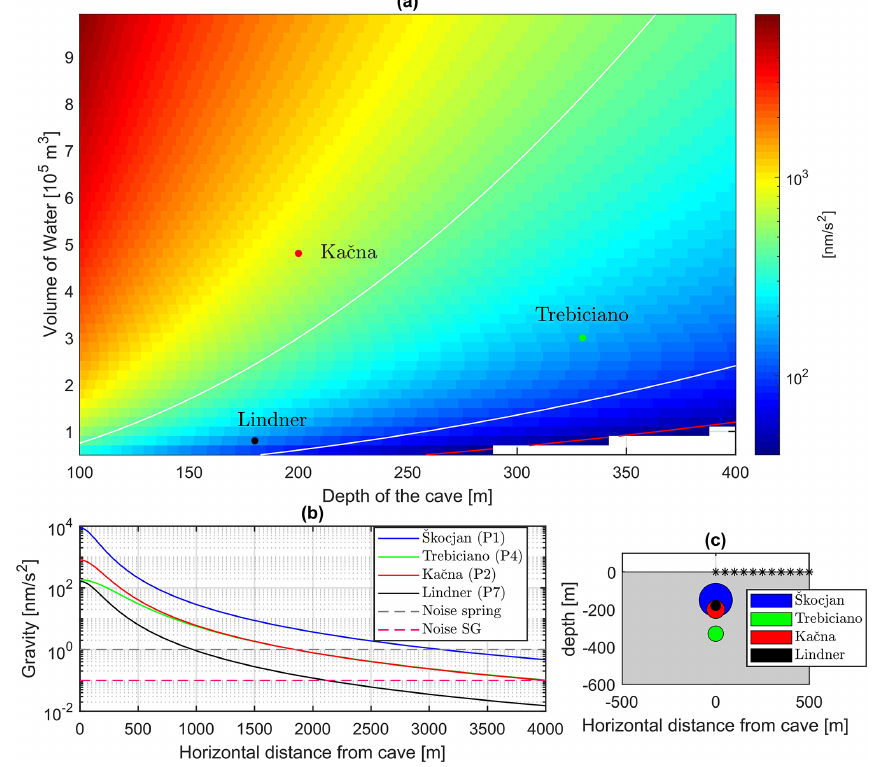
Figure 6. Detectability of gravity signals related to hydrology in karstic areas. (a) Gravity signals simulated for various water volumes stored and depths of the caves. Red line: contour line of 50nms − 2 ; white lines: 100 and 500nms − 2 iso-anomalies. (b) Gravity anomalies for four different cavity volumes filled with water at different depths as a function of the horizontal distance from the cavity centre. Noise levels for a common spring gravimeter and a SG are reported with the dashed lines. (c) Vertical cross-section of the spherical cavities used for approximating the hydrologic gravity effects: black stars report the surface locations where gravity anomalies have been